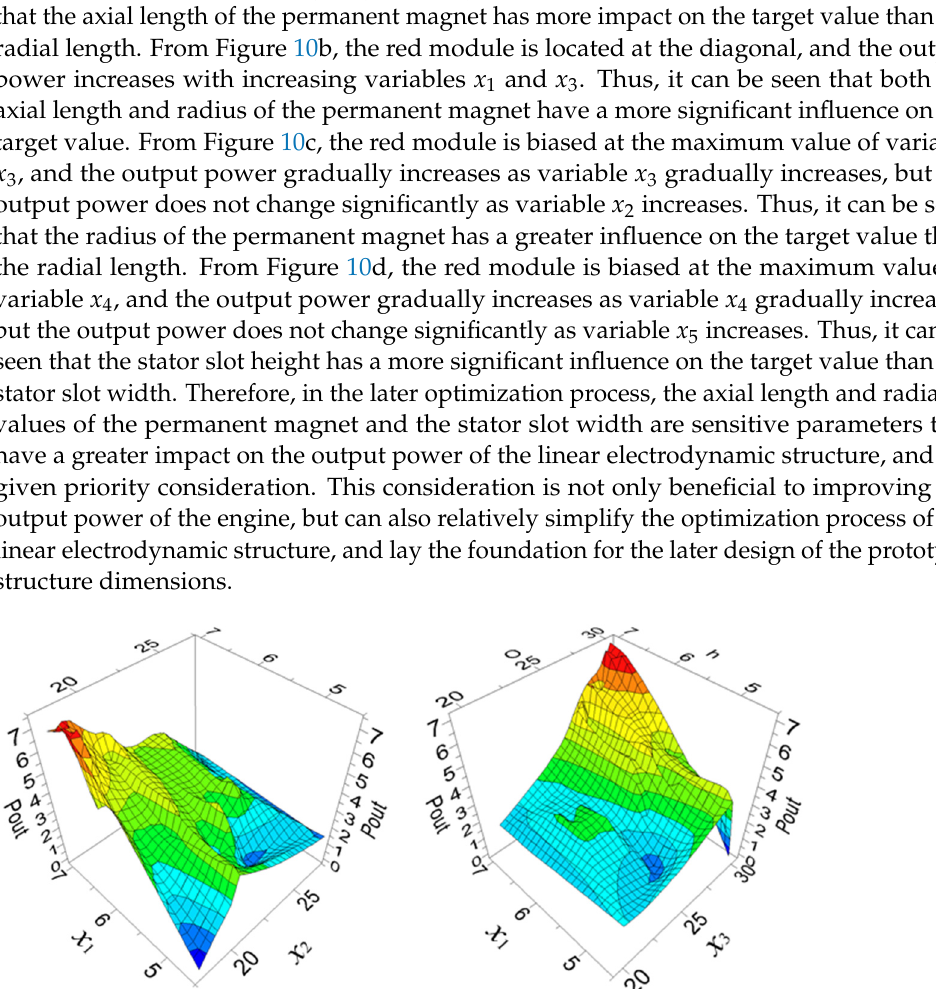
Figure 11. Output power optimization iterative process. 6. Prototype Test The PMPMEE is based totally on the structural precept of the regular internals inside engines and linear generators, modified from a 168 F fuel engine. To confirm the feasibility of the optimization results in this paper, the main components were designed, processed, and assembled according to the designed engineering diagrams of the kinetic and stator assemblies and the structural parameters received after optimization. The test prototype and primary components are shown in Figure 12. The characteristics of the devices used in the experiment are shown in Table 3. 0